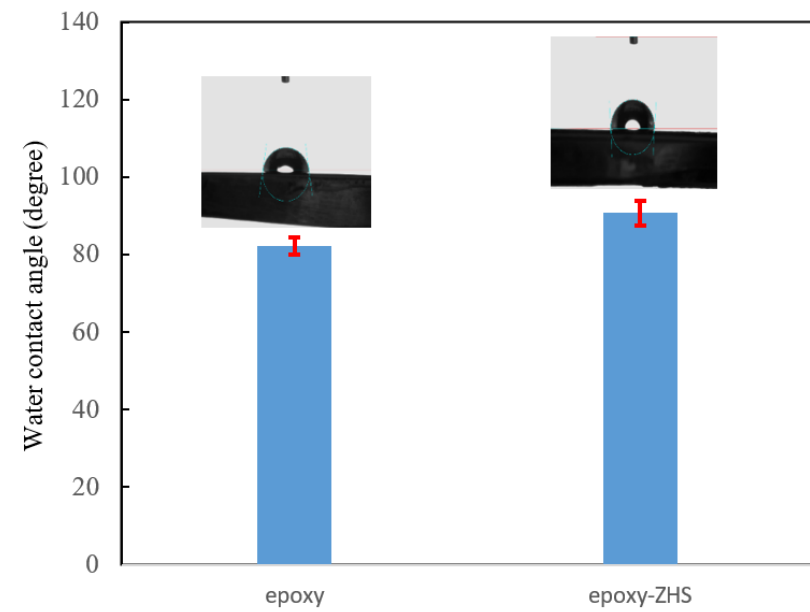
Figure 10. Water contact angle of the neat and ZHS ‐ containing epoxy coatings.